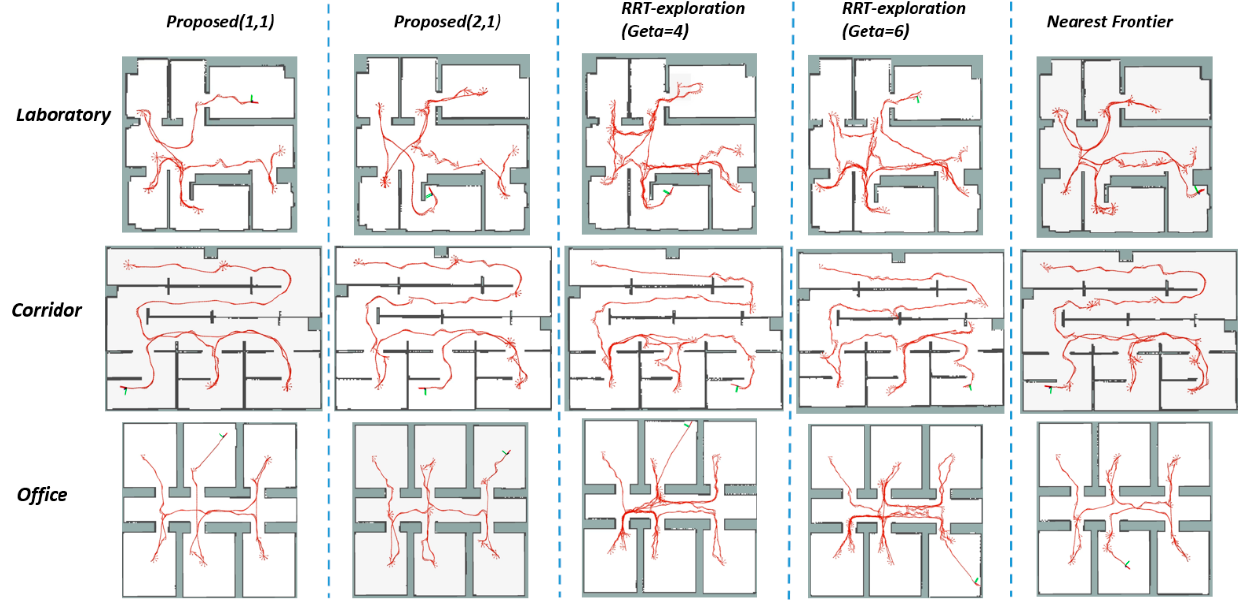
Figure 8. The execution path of different methods in different